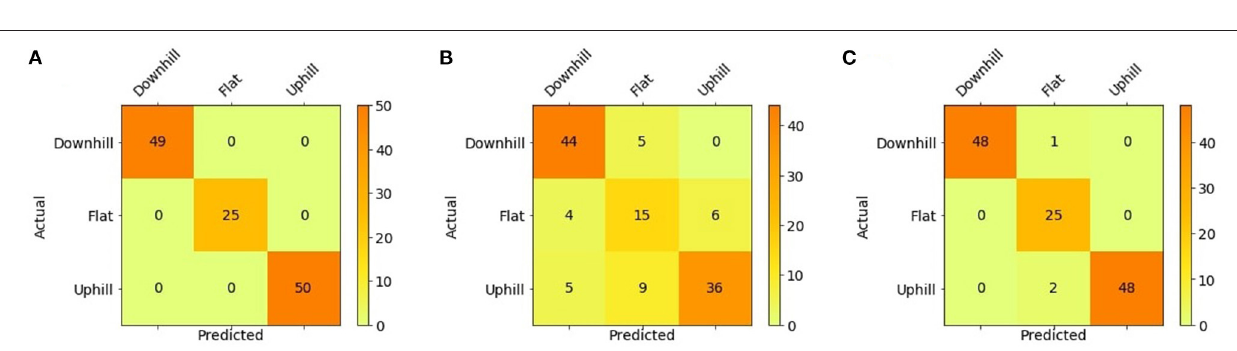
FIGURE 10 | Confusion matrices obtained for different data configurations: (A) learning without faults and testing without faults, (B) learning without faults and testing with faults, and (C) learning with faults and testing with faults. The configuration learning with faults and testing without faults was characterized by a perfect classification and is equivalent to the confusion matrix in (A)